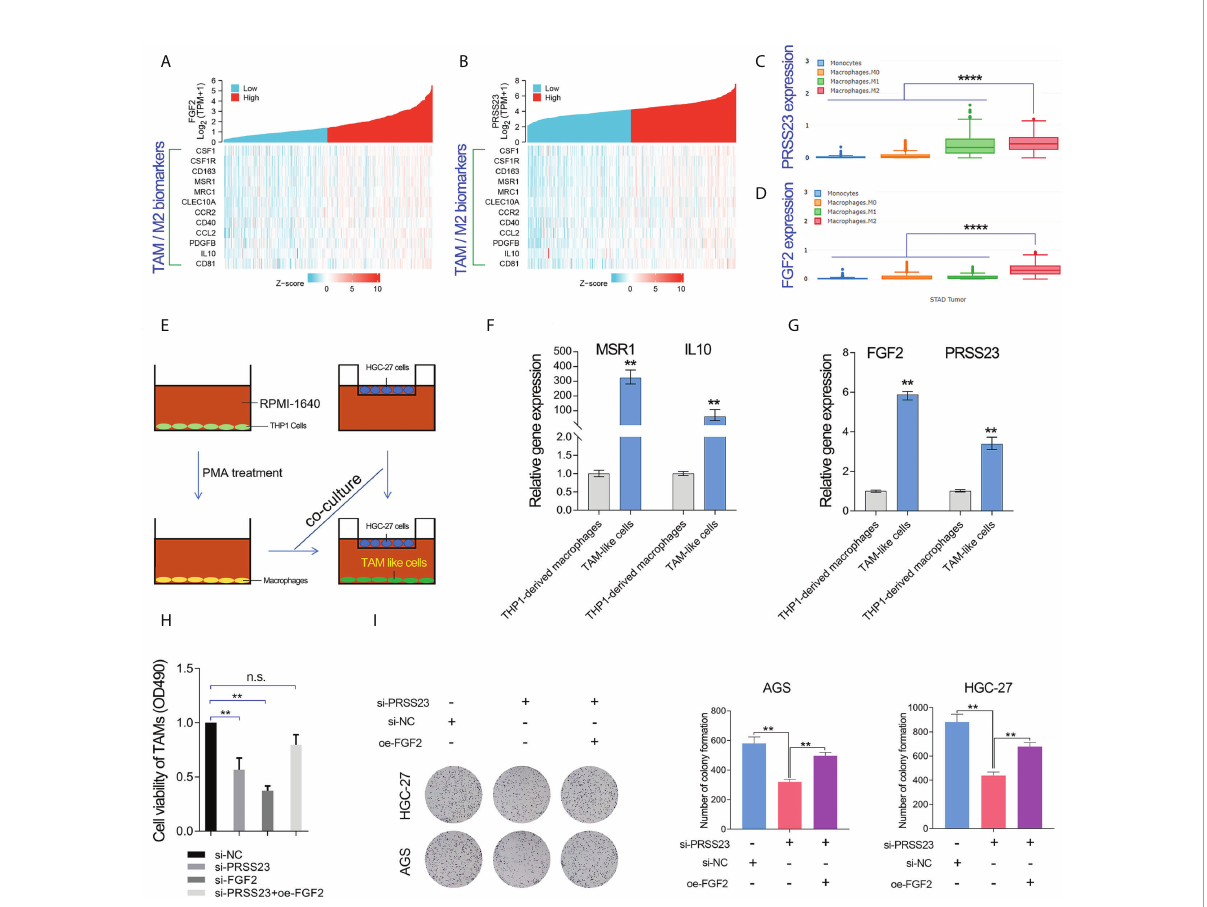
FIGURE 7 PRSS23 enhances TAM in fi ltration by regulating FGF2 expression and secretion. (A) The gene expression correlation between FGF2 and the well- known biomarker genes of TAM/M2 macrophage was analyzed. (B) The gene expression correlation between PRSS23 and the well-known biomarker genes of TAM/M2 macrophage was analyzed. (C, D) PRSS23 and FGF2 was upregulated in M2 macrophages. (E) The TAM-like cells were induced by co-culturing with HGC-27 cells and THP-1 derived macrophages. (F) The well-known biomarkers of TAM/M2 macrophages were greatly upregulated. (G) Both FGF2 and PRSS23 were signi fi cantly upregulated in TAM-like cells. (H) Overexpression of FGF2 rescued the inhibitory effect of survival of TAM-like cells by PRSS23 depletion. (I) Overexpression of FGF2 rescued the inhibitory effect of GC cell proliferation by PRSS23 depletion. **p < 0.01, ****p < 0.0001, ns means no signi fi